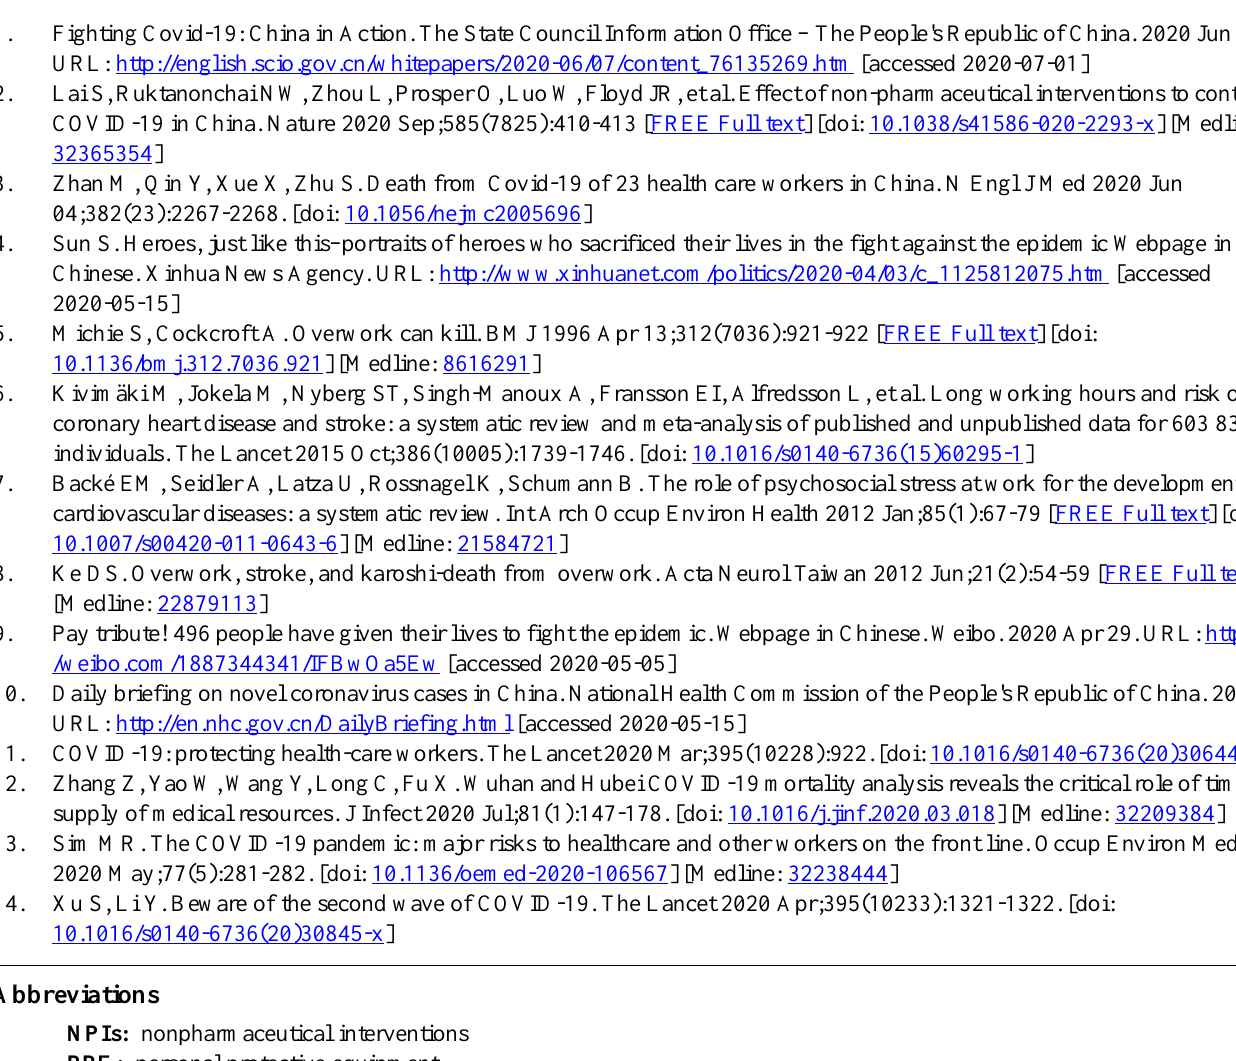
Table S1. Deidentified individual characteristics of documented frontline workers who died due to overwork during the emergency response to COVID-19 between January 20 and April 26, 2020, in